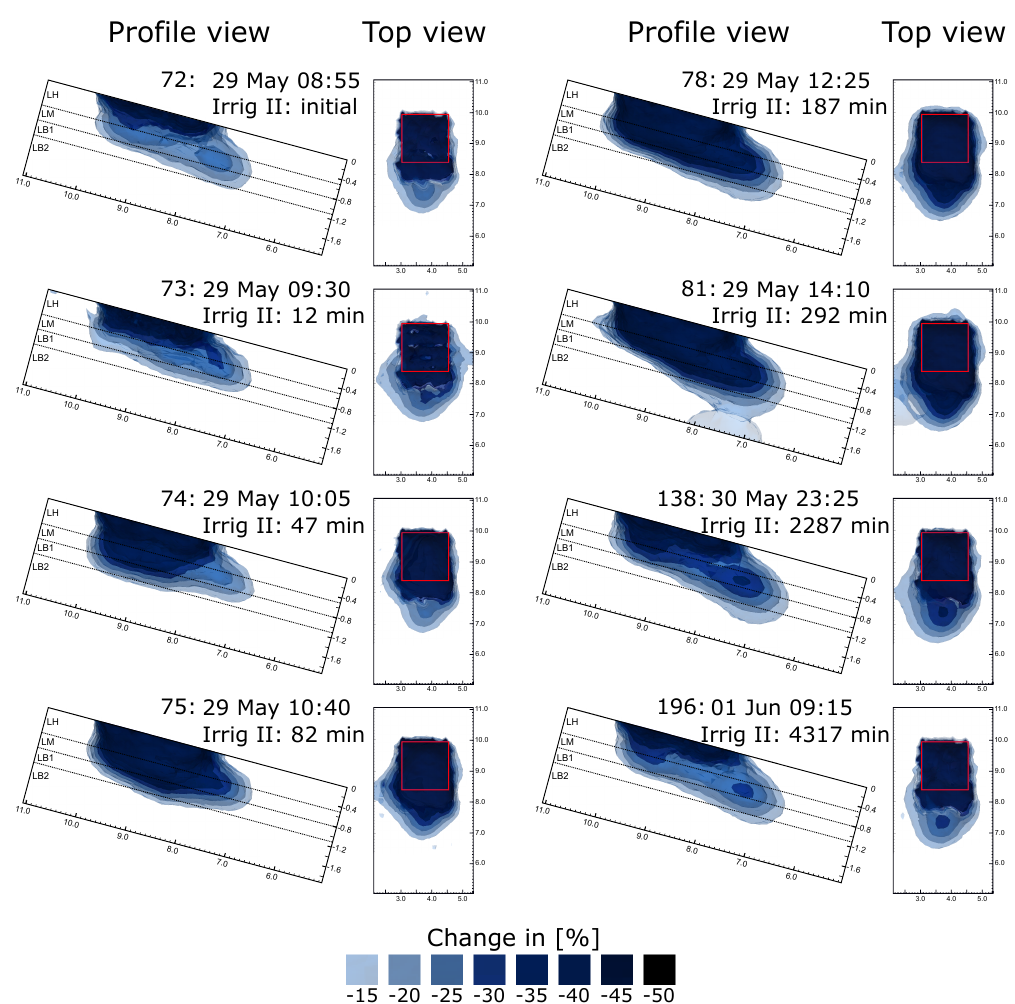
Figure 7. Spatial distribution of resistivity change (profile and top view of the 3-D model with transparent isosurfaces and a threshold of 15%) for selected time steps during the second